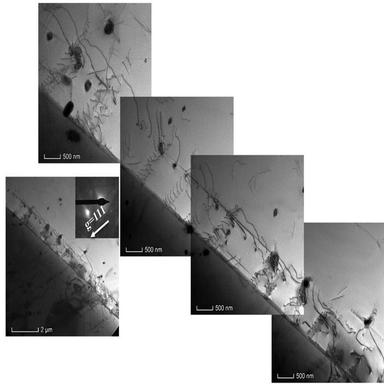
Post-test TEM microscopic images of Alloy 709 crept at 500 ◦C, showing the slipping systems near the grain boundary and dislocation pile-up.